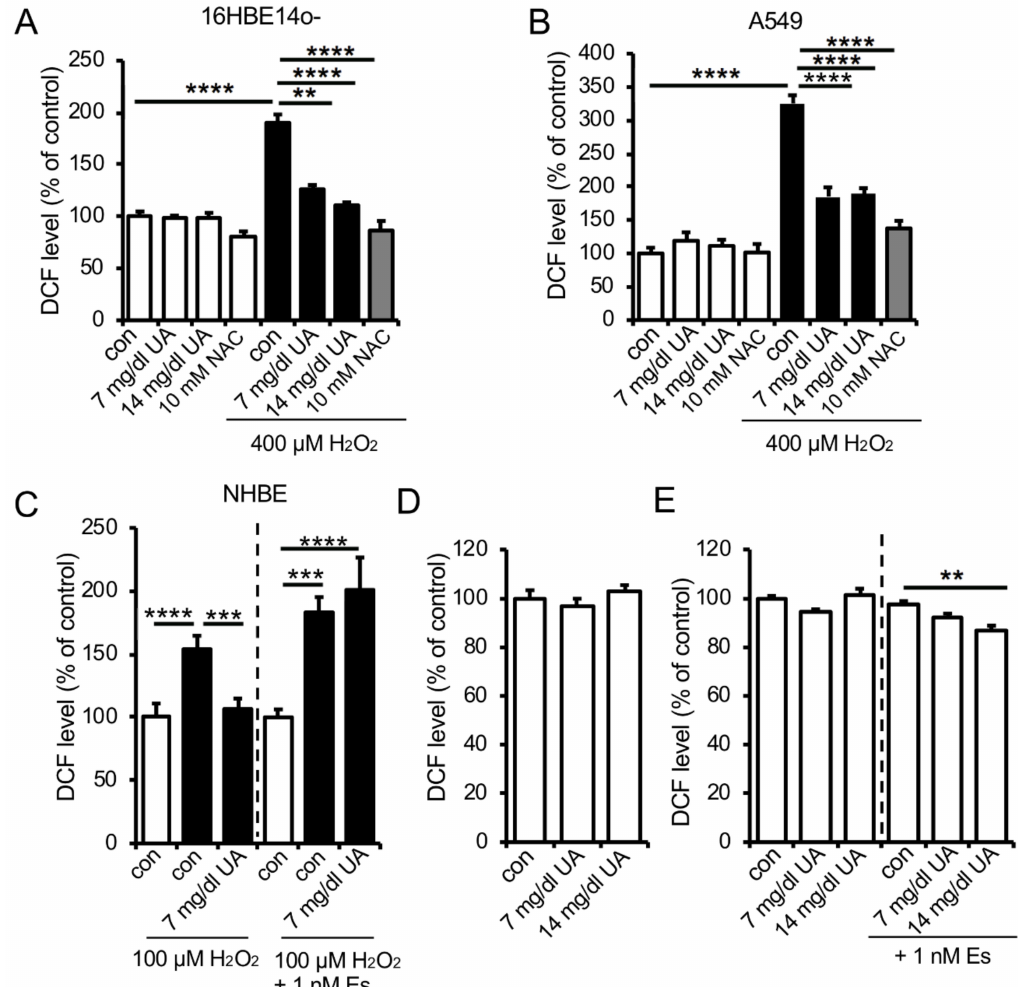
Figure 4. UA suppresses hydrogen peroxide (H 2 O 2 )-induced oxidative stress in human lung epithelial cells. ( A – C ) H 2 O 2 -induced intracellular ROS level in human lung epithelial cells treated with UA. 16HBE14o- cells ( A ) or A549 ( B ) cells were stained by CM-H 2 DCFDA (DCFDA) and treated with 7 or 14 mg / dL UA and 10 mM N-acetylcysteine (NAC) as a positive control for 30 min before incubating with 400 µ M H 2 O 2 for 30 min at 37 ◦ C. ( C ) Female-derived primary human bronchial epithelial (NHBE) cells incubated with 1 nM 17 β -estradiol for 24 h were stained by 5(-and-6)-chloromethyl-2’,7’-dichlorodihydro-fluorescein diacetate acetyl ester (DM-DCFDA) before incubating with 100 µ M H 2 O 2 for 20 min after treating with 7 mg / dL UA for 20 min at 37 ◦ C. 2’,7’-dichlorodihydro-fluorescein (DCF) levels were measured using a fluorescent microplate reader. n = 4–5 / group. Data are indicated as % of control and expressed as mean ± SEM. ( D – E ) E ff ects of long-term UA treatment on reactive oxygen species (ROS) production in human lung epithelial cells. ( D ) 16HBE14o- cells were stained by DCFDA after incubating with 7 or 14 mg / dL UA for 48 h at 37 ◦ C. ( E ) Female-derived NHBE cells incubated with 1 nM 17 β -estradiol in media for 48 h were stained by DCFDA and then incubated with 100 µ M H 2 O 2 for 20 min after treating with 7 mg / dL UA for 20 min at 37 ◦ C. DCF levels were measured using a fluorescent microplate reader. n = 4–5 / group. Data are indicated as % of control and expressed as mean ± SEM. Data are mean ± SEM; n = 3 / group. ** p < 0.01, and *** p < 0.001, **** p < 0.0001were assessed by the Tukey–Kramer